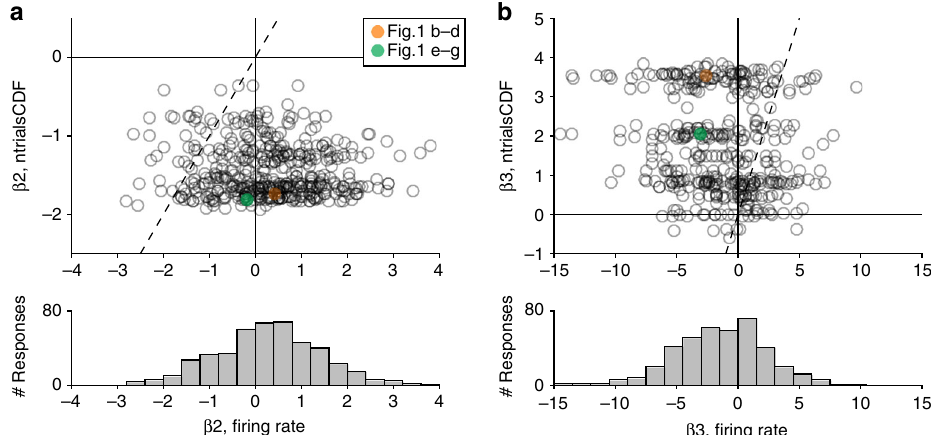
Fig. 2 Quasi-linear coding of offer values, population analysis ( N = 447). a Quadratic term. Each data point in the scatter plot represents one response. The x -axis and y -axis represent β β 2, fi ring rate and 2, ntrials CDF , respectively. The dotted line represents the identity line, and the responses illustrated in Fig. 1 are highlighted. The histogram recapitulates the distribution for β 2, fi ring rate . Since low offer values were always over-represented in the experiments, generally β < 0. In contrast, measures for β 2, ntrials CDF 2, fi ring rate were broadly scattered above and below zero (see histogram). b Cubic term. Same conventions as in a . Generally, β 3, ntrials CDF > 0. In contrast, measures for β 3, fi ring rate were broadly scattered above and below zero. Notably, on average across the population, measures for β 2, fi ring rate were close to, but signi fi cantly above zero (mean( β 2, fi ring rate ) = 0.28; p < 10 -6 , t -test). Conversely, measures for β 3, fi cantly below zero (mean( β = − 1.42; p < 10 − 12 , t -test). In both cases, the deviance from zero measured for β fi ring rate were close to, but signi 3, fi ring rate ) β (cid:129) rate was in the direction opposite to that observed for the corresponding , ntrials CDF , indicating that tuning functions did not match ntrials CDF averaged across sessions. We return to these deviances later in the